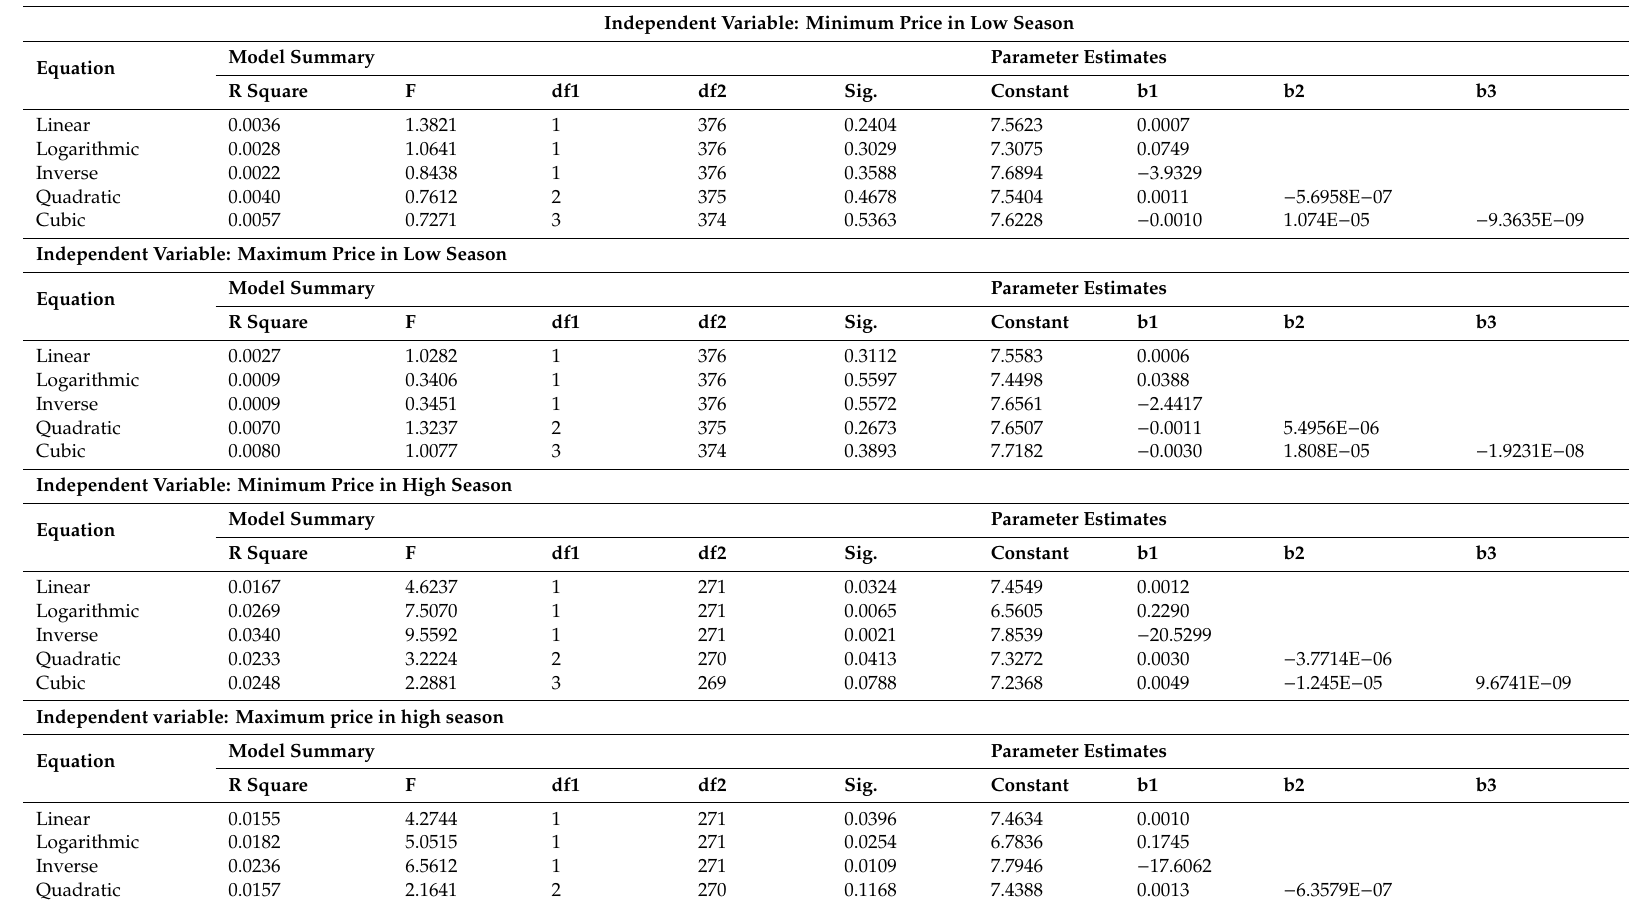
Table 2. Model summary and parameter estimates of regression analysis in all destinations, with value as dependent